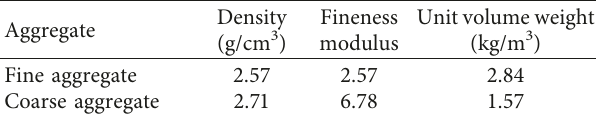
Table 3: Physical properties of aggregates.